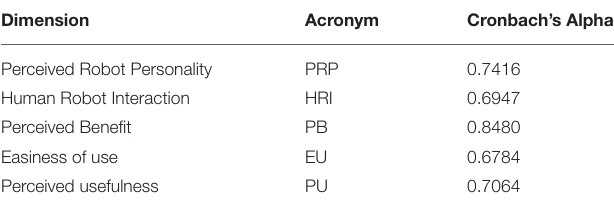
TABLE 3 | The Cronbach’s alpha values of the Robot-Era Inventory scales.